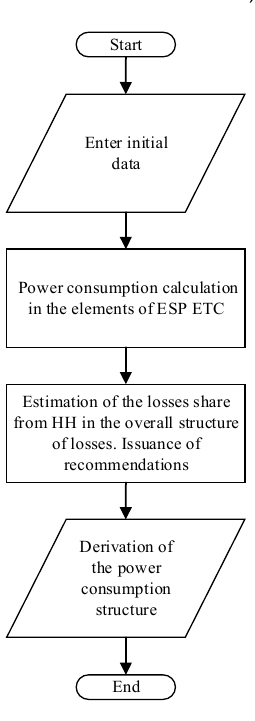
Figure 4. Algorithm for calculating losses in ESP ETC elements, taking into account the influence of harmonics. of